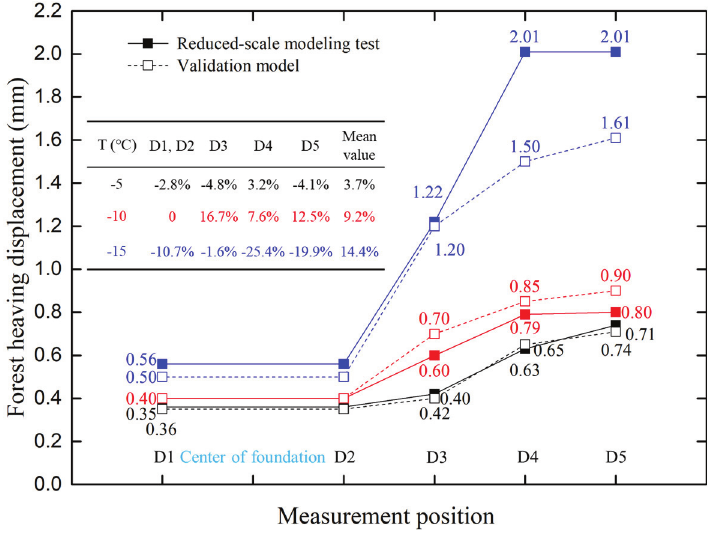
Figure 13. Comparison of frost heave displacement between numerical modeling and reduced-modeling tests.